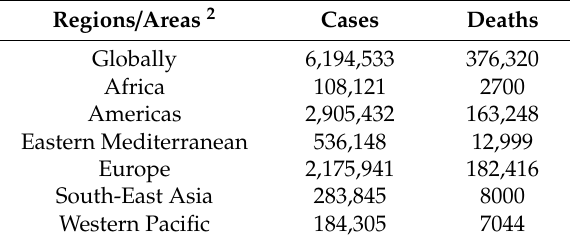
Table 1. Global Coronavirus Cases and Deaths 1